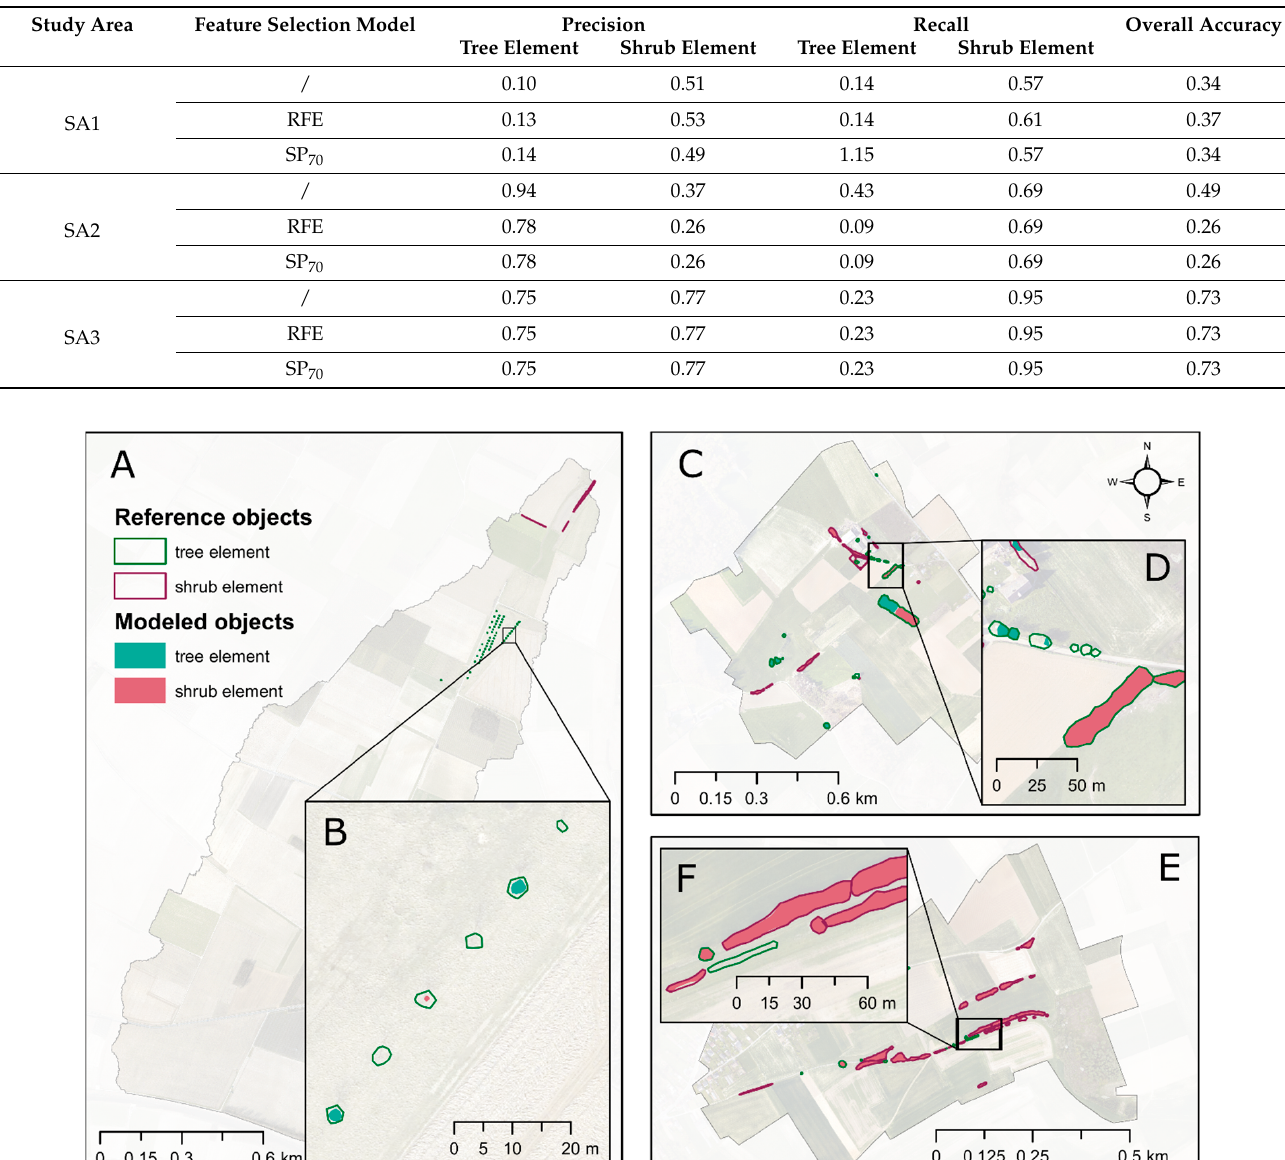
Table 8. Precision, recall, and overall accuracy of the developed workflow.